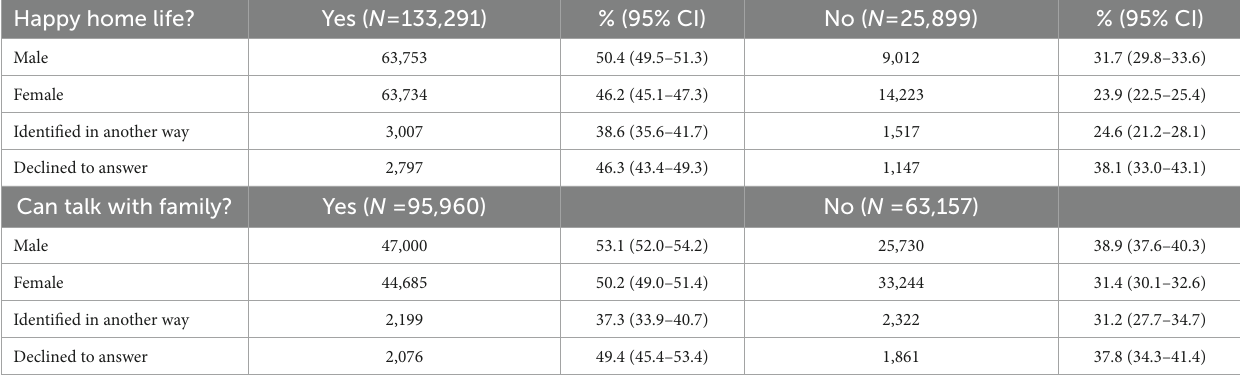
TABLE 2 Percentage of students having frequent family meals by family dynamics and gender. Happy home life?